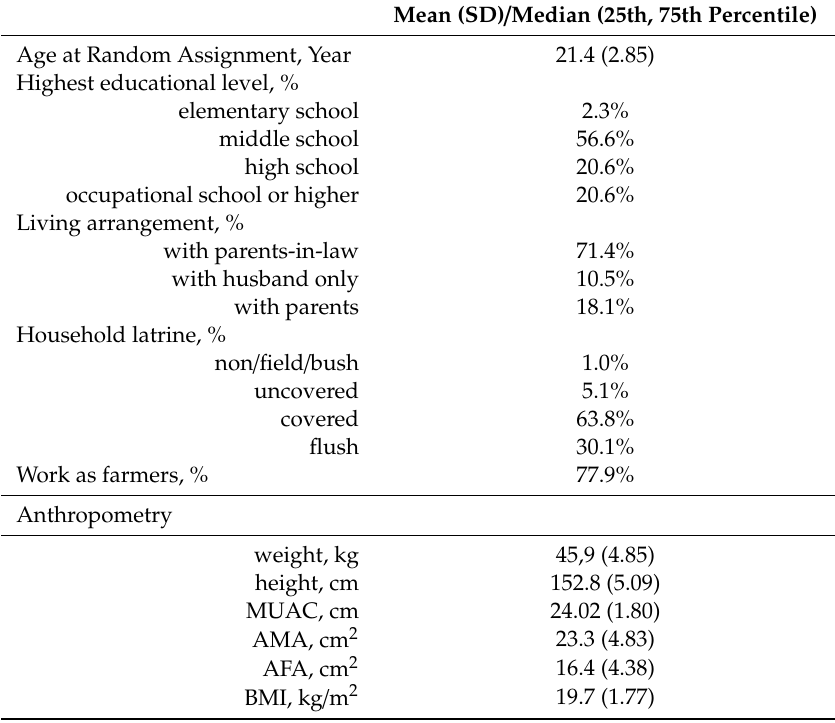
Table 1. Characteristics of the study population at baseline ( n = 317)